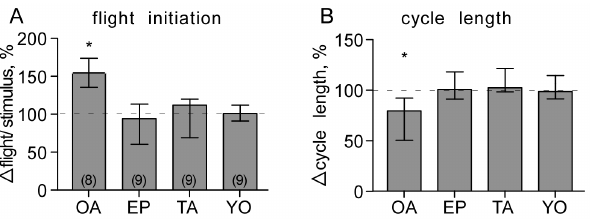
Figure 10. Relative changes (%) in A the effectiveness of wind stimulation to initiate flight, and B cycle length (WD-WD) of wind evoked fictive flight after treatment with (from left to right): octopamine (OA, 5 mM), the octopamine receptor antagonist epinastine (EP, 1 mM), tyramine (TA, 5 mM) and the tyramine receptor antagonist yohimbine (YO, 1 mM). Numbers in parenthesis (in A ) give the number of evaluated preparations for each test group. Columns give the median, ticks the interquartile range and asterisks significant changes (Wilcoxon Signed Rank test *p , 0. 05).31.